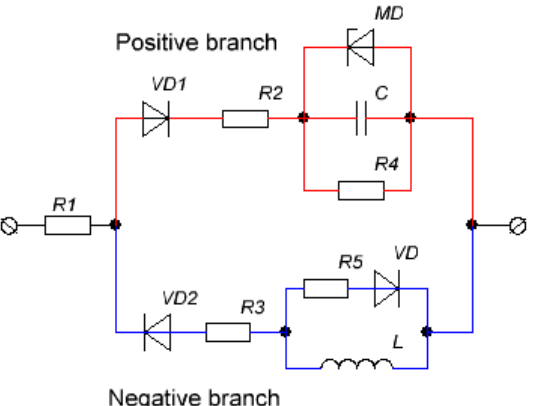
Figure 3. Simplified equivalent circuit of a PEO load for positive and negative polarity, based on data from Reference [50]. MD—zener diode of microdischarges; R1—resistance of electrolyte; R2,R3—resistances of the coating for positive and negative current; R4—differential resistance of microdischarges; R5—resistance characterising self-decay of the negative induced states; C—capacitance of metal-oxide–electrolyte junction under reveres bias; L—virtual inductance attributed to slow chemical processes (absorption, desorption, surface diffusion, etc.); ideal diodes VD1,2 formally separate positive and negative branches.